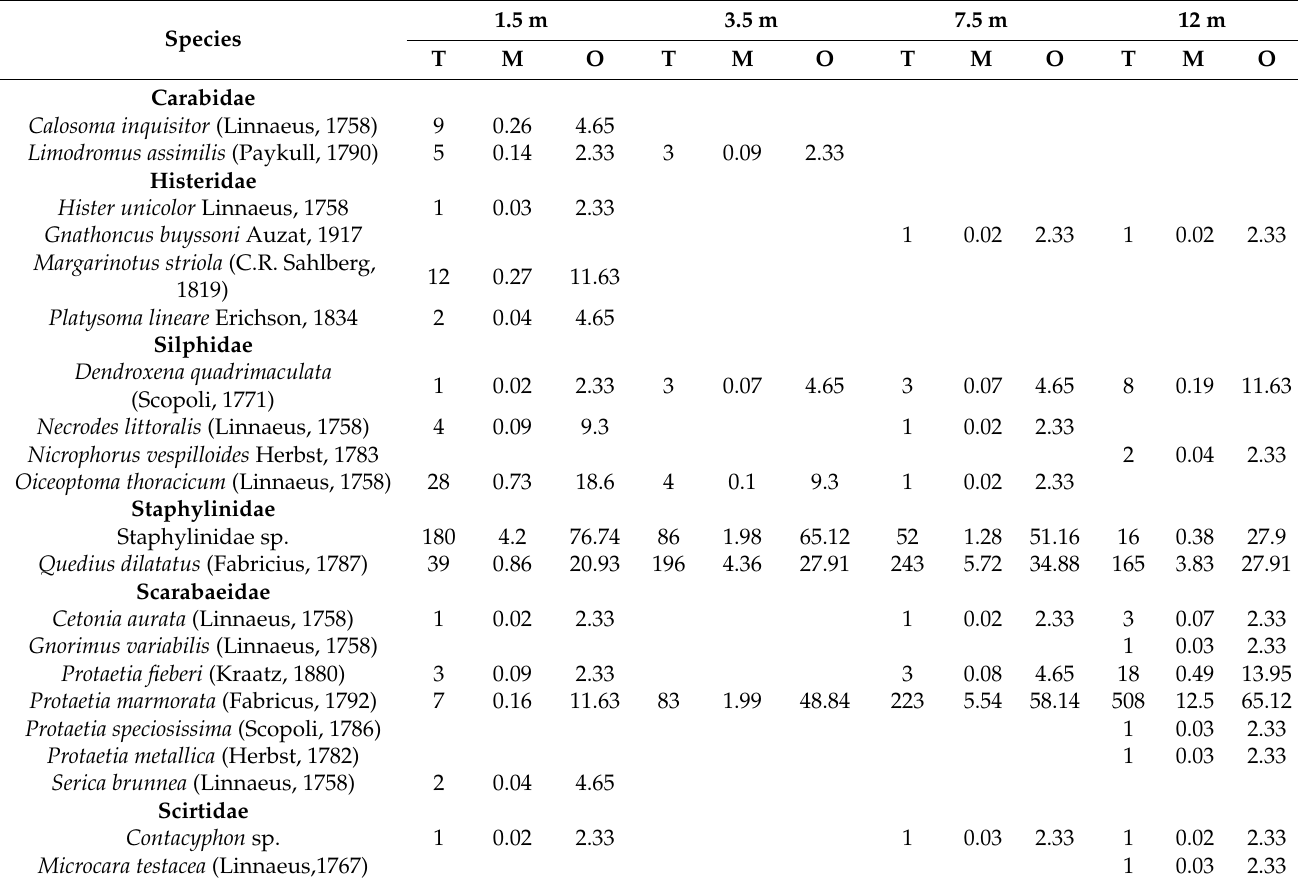
Table A1. Species diversity, total (T), mean number (M, %), and occurrence (O, %) of coleoptera individuals collected using beer traps at different